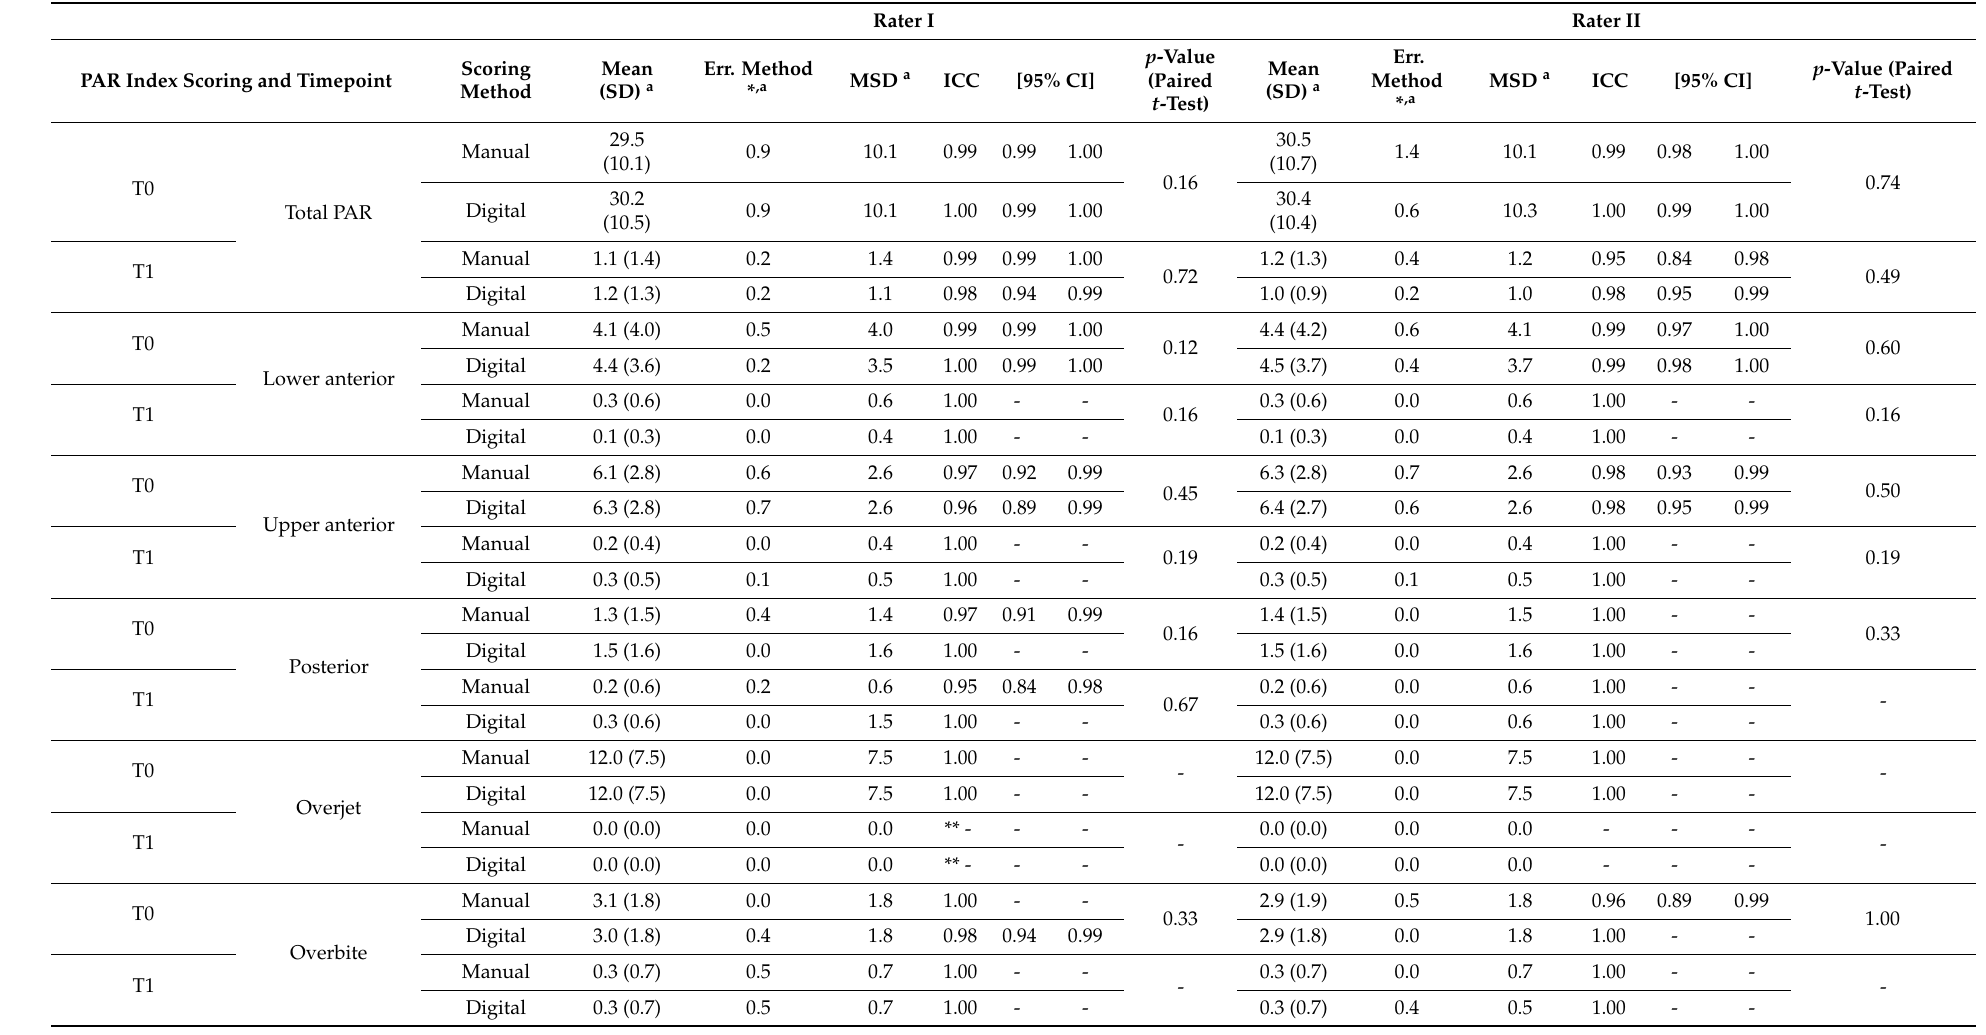
Table 2. Intra-rater variability (error of the method and Minimum Standard Deviation (MSD)) and reproducibility (ICC) according to time point and method, for both raters. Paired sample t -tests comparing both